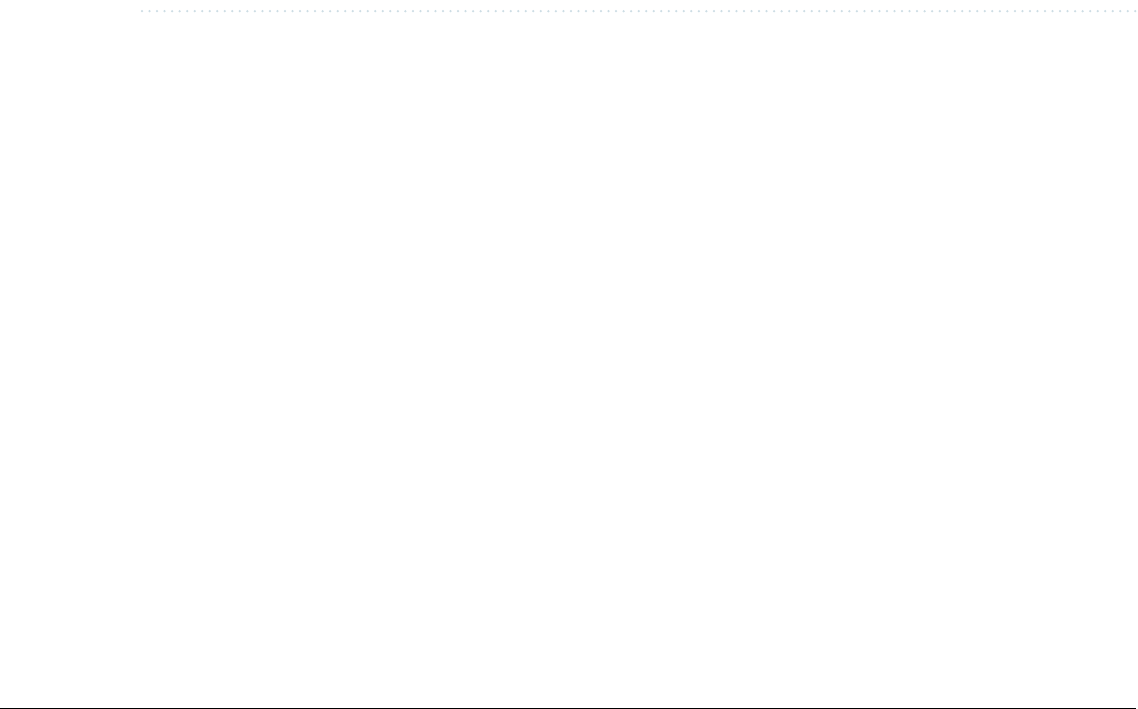
Figure 7. Target detection results of different models under different opposite